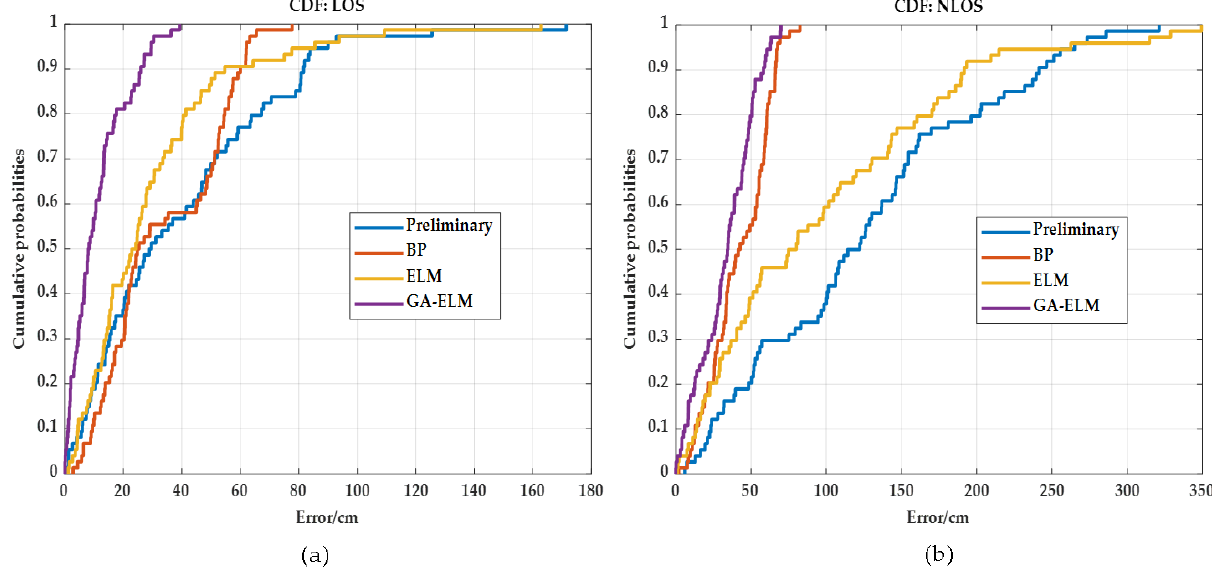
Figure 15. The comparison of CDFs for different algorithms under LOS and NLOS: ( a ) Without signal interference; ( b ) With signal interference.